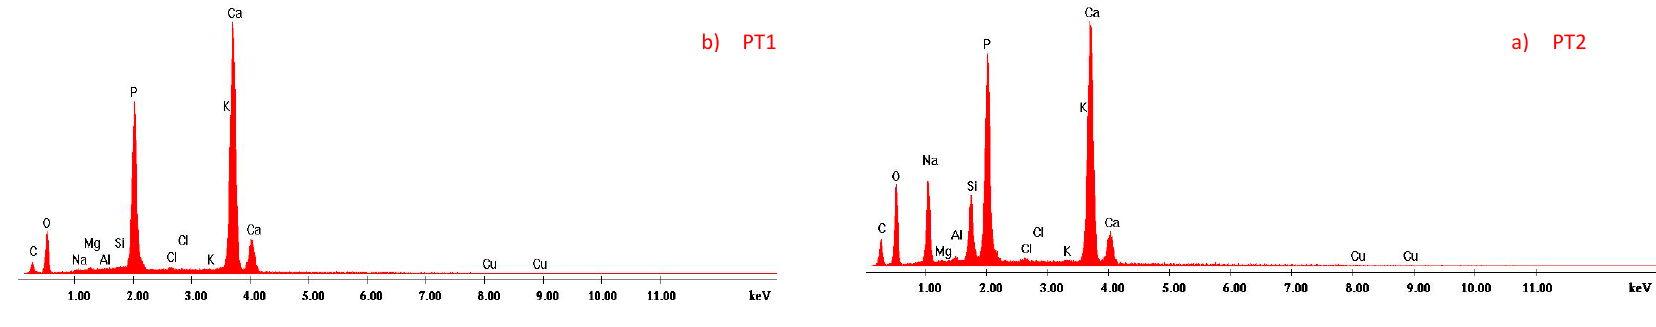
Figure 47. EDS spectra acquired on the ( a ) core and ( b ) rim of the inclusions. Note: Na and Si enrichment in the rim; O, Na, Mg, Si, Al, Cl, K, and Cu are due to the interference of the glassy matrix in the measurement (KH_G10 light blue natron-based Egypt I glass tessera from Khirbet al-Mafjar, Palestine 33).